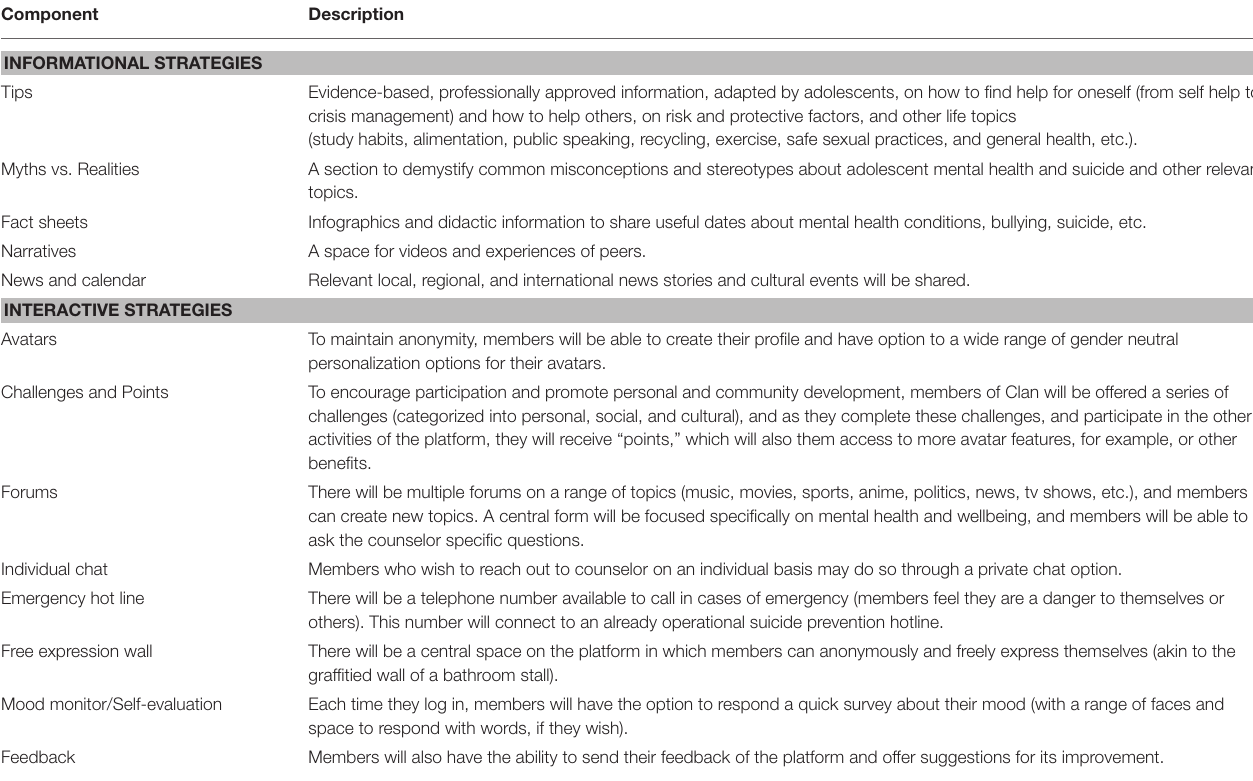
TABLE 1 | Description of the Intervention. Component Description INFORMATIONAL